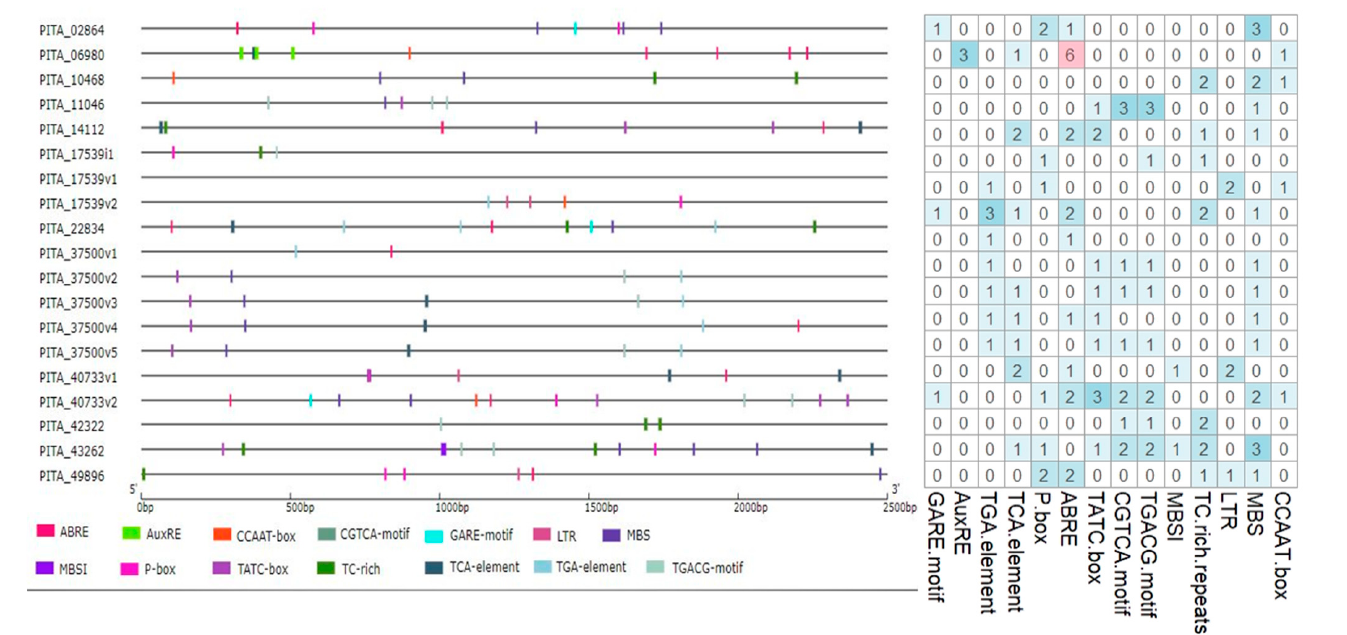
Figure 4. Analysis of cis -acting elements in the promoter region of the loblolly pine CYP720B genes. The left picture shows the position of the cis -acting in the upstream 2500 bp sequence, the right picture shows the number of each cis -acting element, and the number in the boxes indicates the number of cis -acting elements, The more the number, the darker the color, red means the